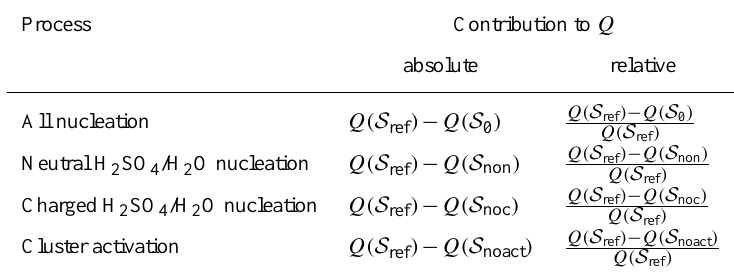
Table 3. Contributions of individual particle formation processes to a model quantity Q , calculated from the simulations listed in Table 2.